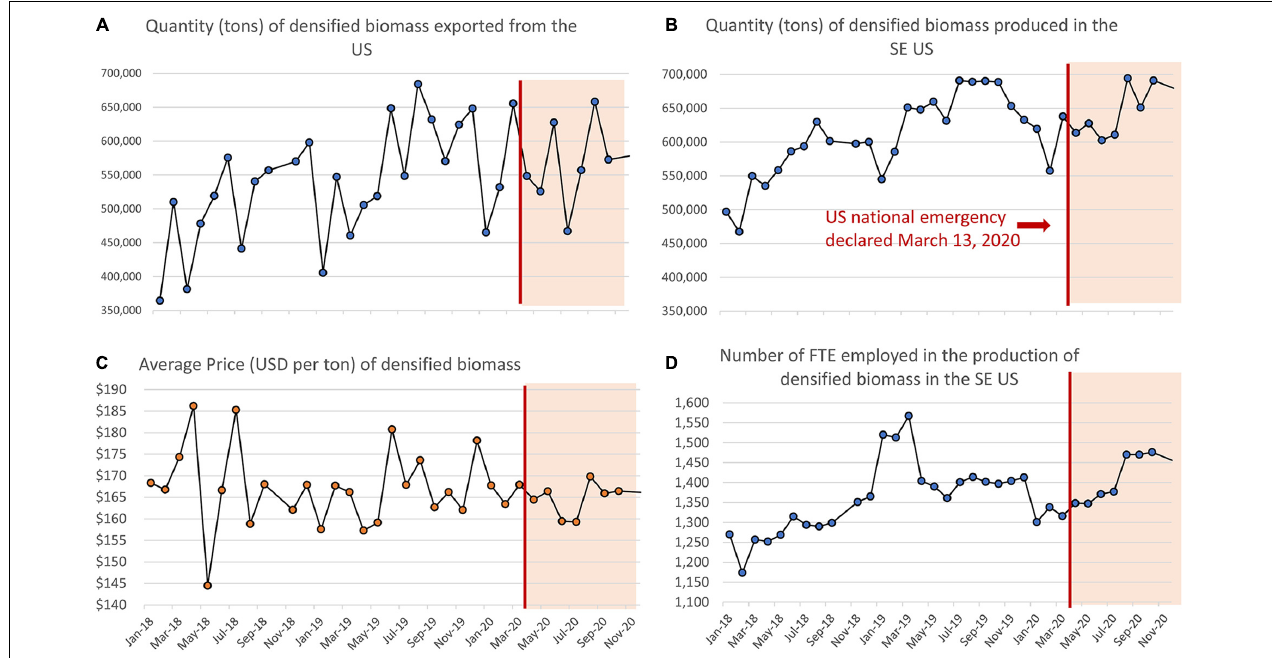
FIGURE 4 | Changes over time in the quantity (tons) of densified biomass (A) exported from the United States and (B) produced in the SE United States; and (C) average price per ton of densified biomass, and (D) number of full-time equivalent employees (FTEs) employed in the production of densified biomass in the SE United States. Data from United States Energy Information Administration. A national emergency was declared in the United States on March 13, 2020 (as indicated by the red line and shaded